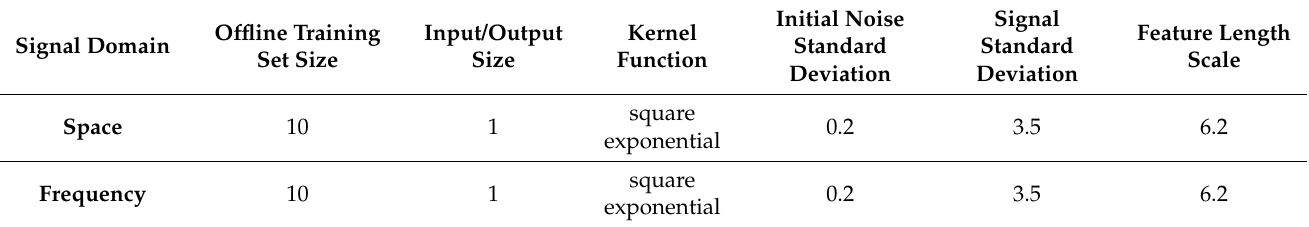
Table 2. Parameter setting of the GRP-based interference activity prediction model.